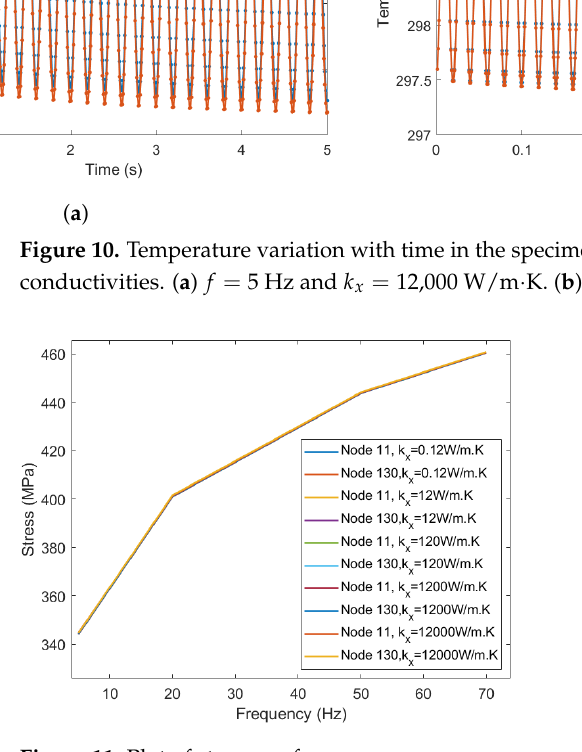
Figure 11. Plot of stress vs.